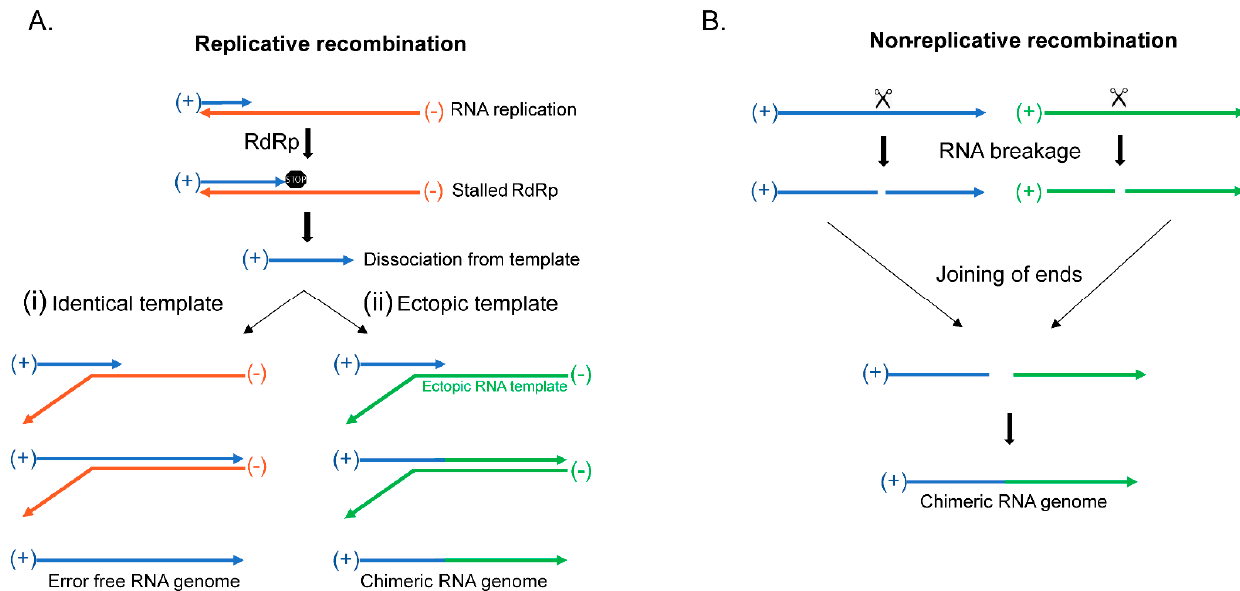
Figure 2. Viral RNA recombination. ( A ) Replicative recombination begins after incomplete RNA replication resulting in the dissociation from the template and rebinding with another RNA molecule to complete replication. (i) RNA template rebinding at a homologous location in an identical RNA template results in error-free recombination. (ii) RNA template rebinding in an ectopic RNA molecule creates a chimeric molecule. ( B ) Non-Replicative RNA recombination occurs through a yet unknown mechanism, which can involve breakage and joining of two different RNA molecules to create a chimeric RNA molecule.